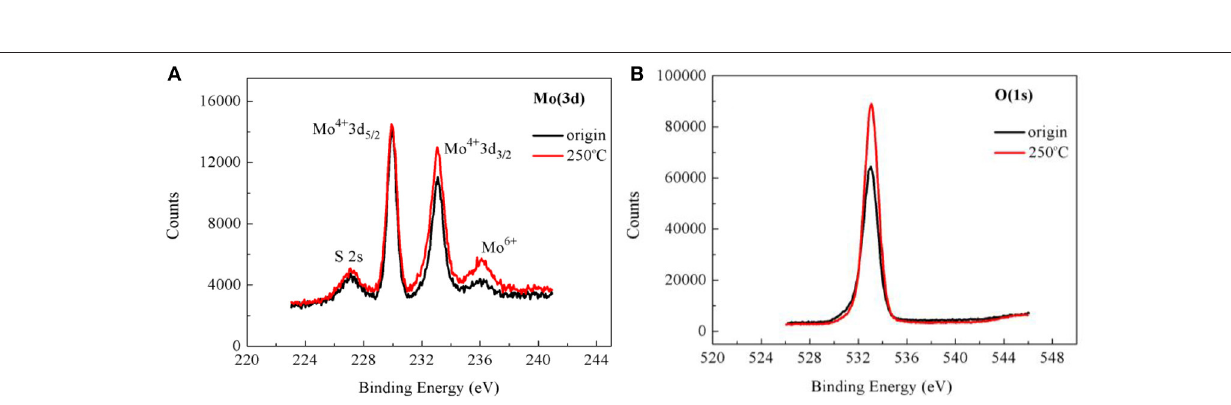
FIGURE 4 | X-ray photoelectron spectroscopy (XPS) spectra of the monolayer MoS 2 film before and after baking at 250 ◦ C for 2h under air. (A) The XPS spectra of Mo(3d) atoms in the samples before and after baking. (B) The XPS spectra of O(1s) atoms in the samples before and after baking.